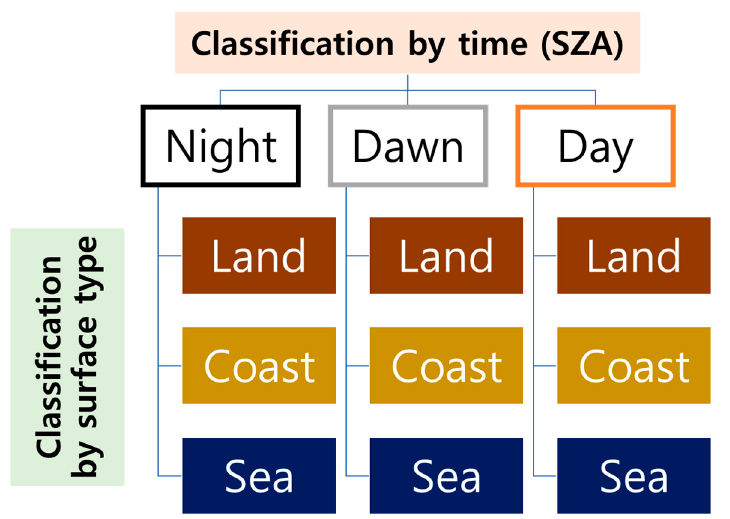
Figure 3. Differentiation of fog detection algorithms, according to the solar zenith angle (SZA) and geographic location.